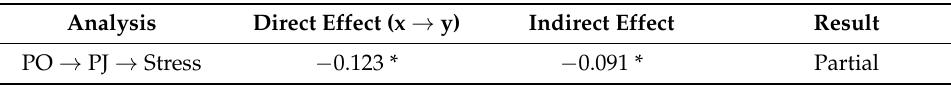
Table 6. Bootstrap mediation analysis results.